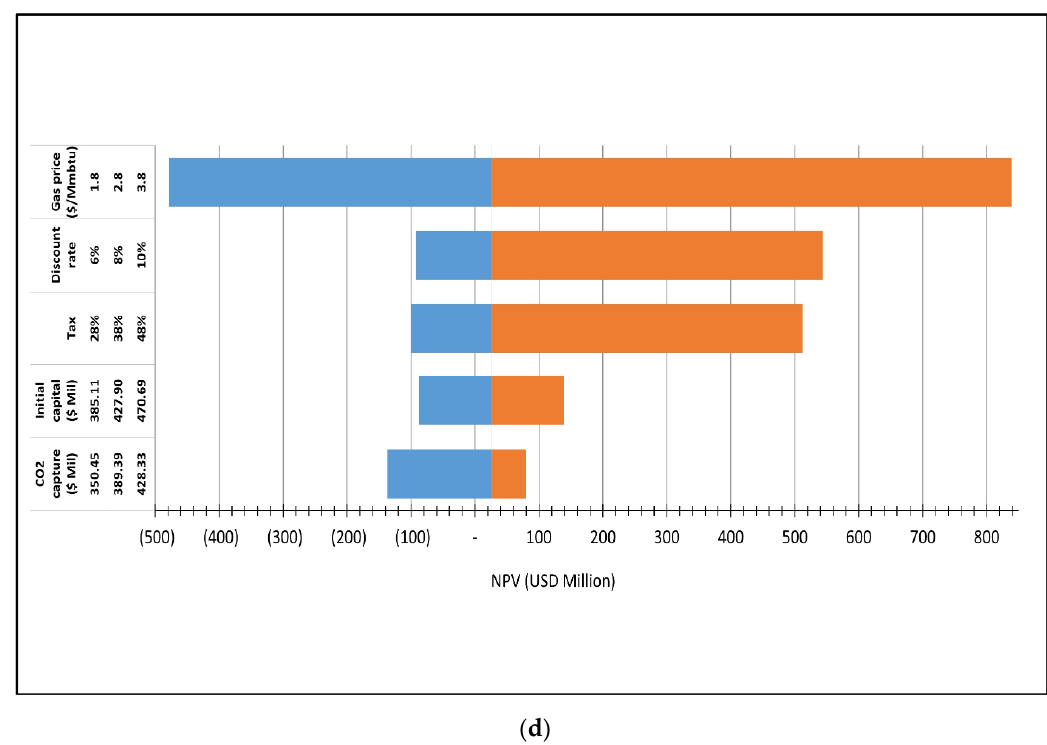
Figure 6. ( a ) Sensitivity analysis (SA) of Net Present Value (NPV) for CO 2 capture using membrane. ( b ) SA of NPV for CO 2 capture using chemical absorption (Amine). ( c ) SA of NPV for CO 2 capture using physical absorption solvent (Selexol). ( d ) SA of NPV for CO 2 capture using cryogenic distillation.